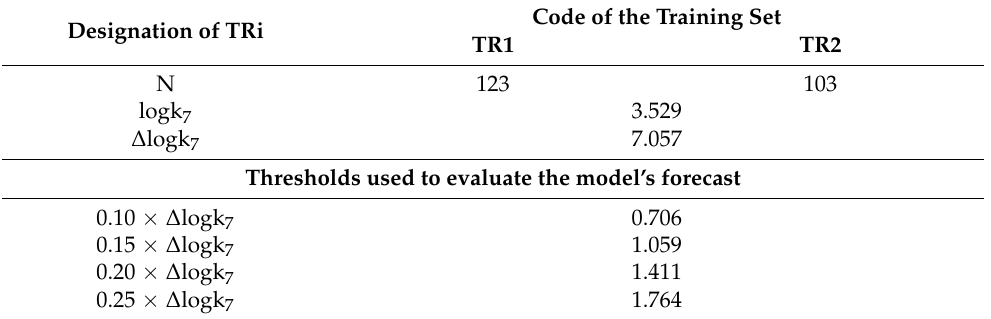
Table 6. Statistical characteristics of the training sets TR1, TR2.